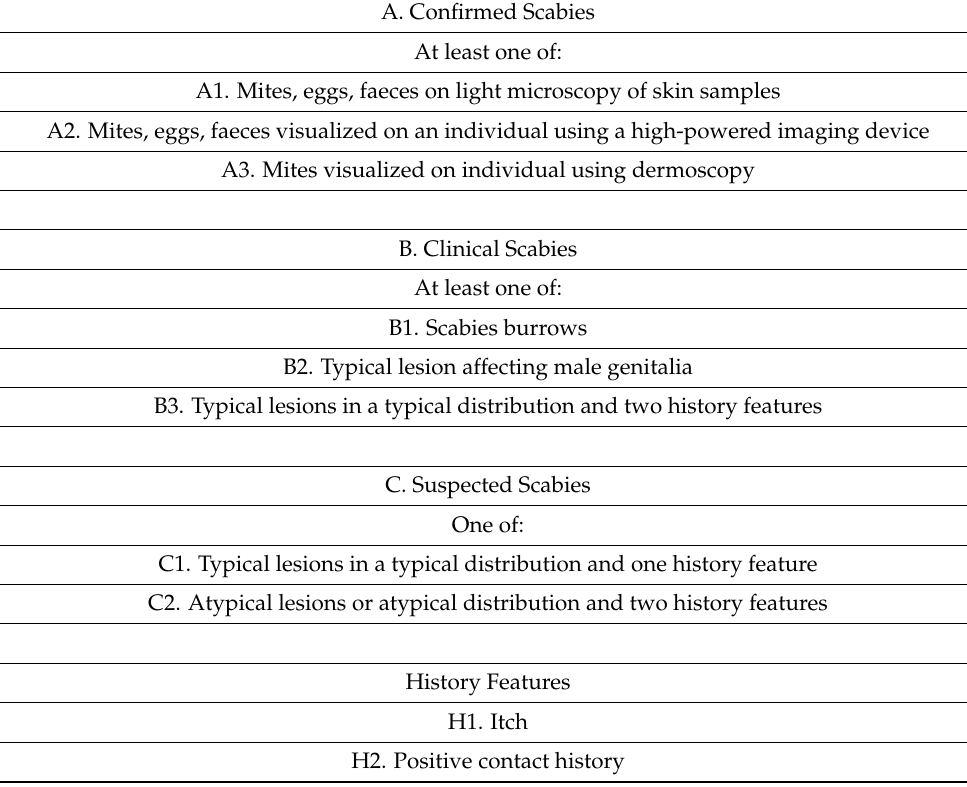
Table 1. Diagnostic criteria established in 2020 by IACS (International Alliance for the Control of